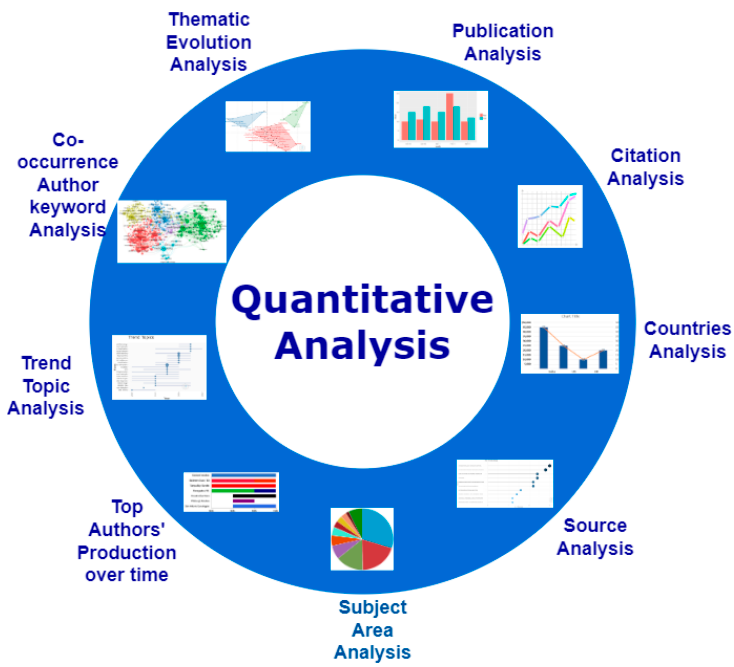
Figure 7. Quantitative analysis.